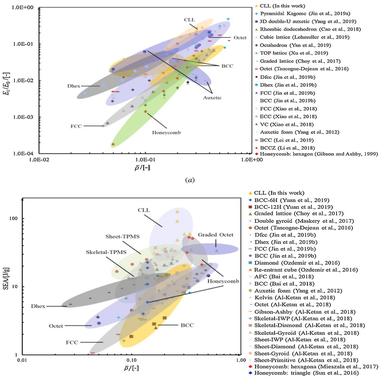
Comparison amongst different lattice materials: (a) relative elastic modulus vs. relative density; (b) specific energy absorption vs. relative density. (,,,,).